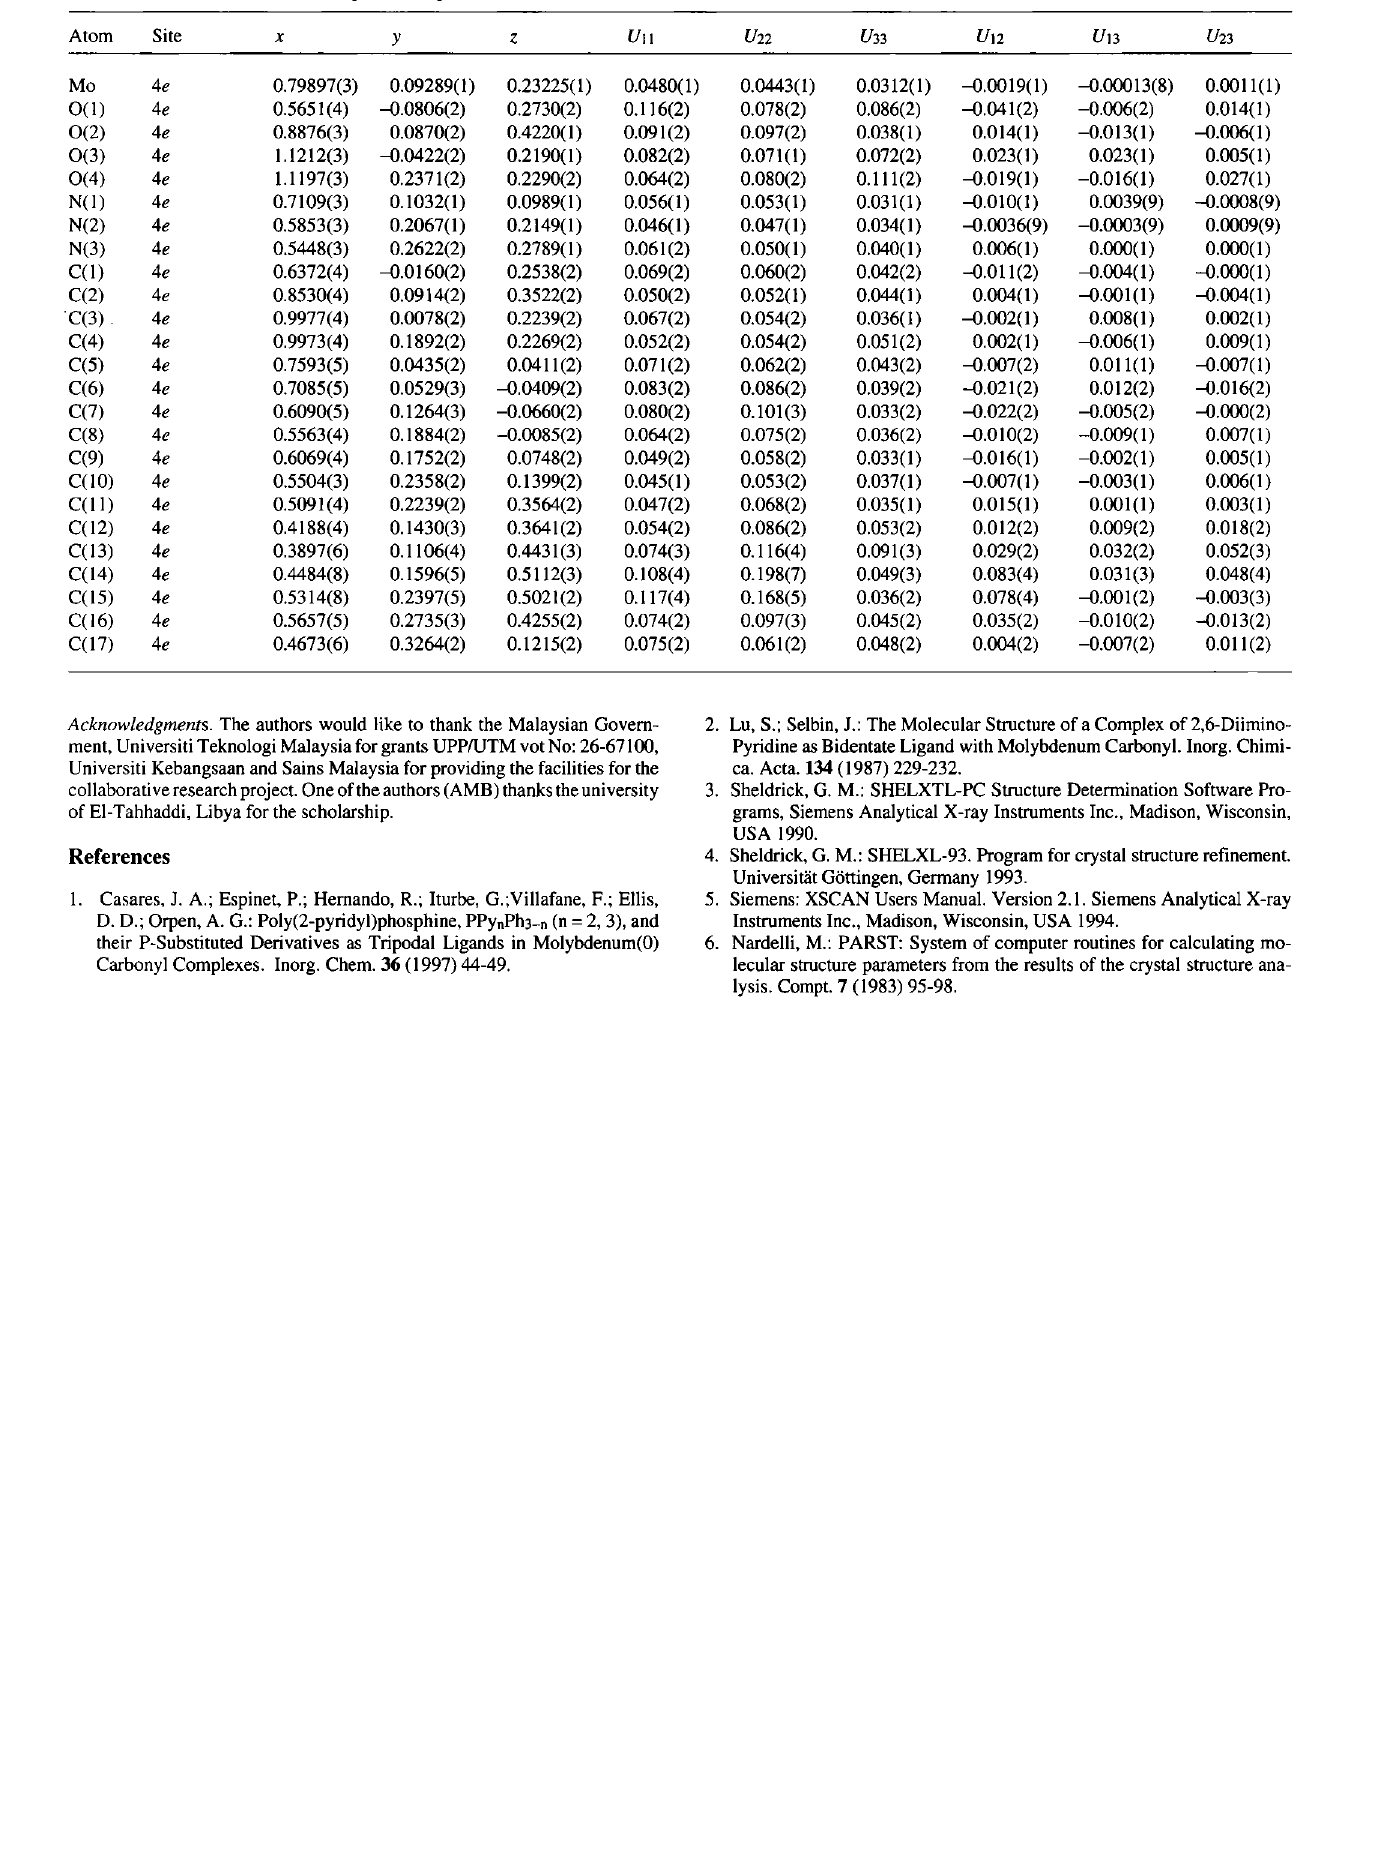
Table 3. Atomic coordinates and displacement parameters (in Ä 2